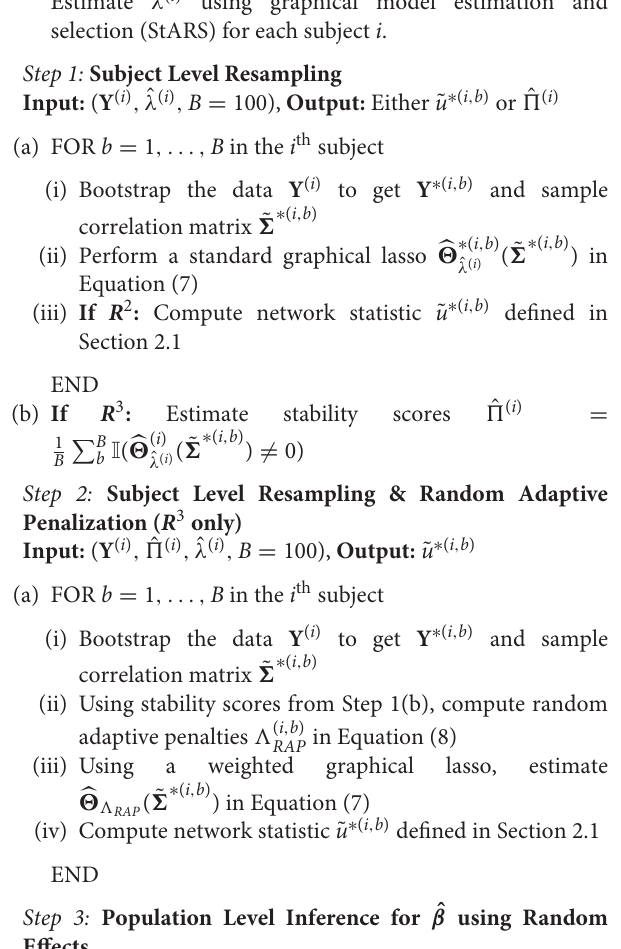
Algorithm 1 : R 2 and R 3 Procedures for Testing Covariates Effects on Network